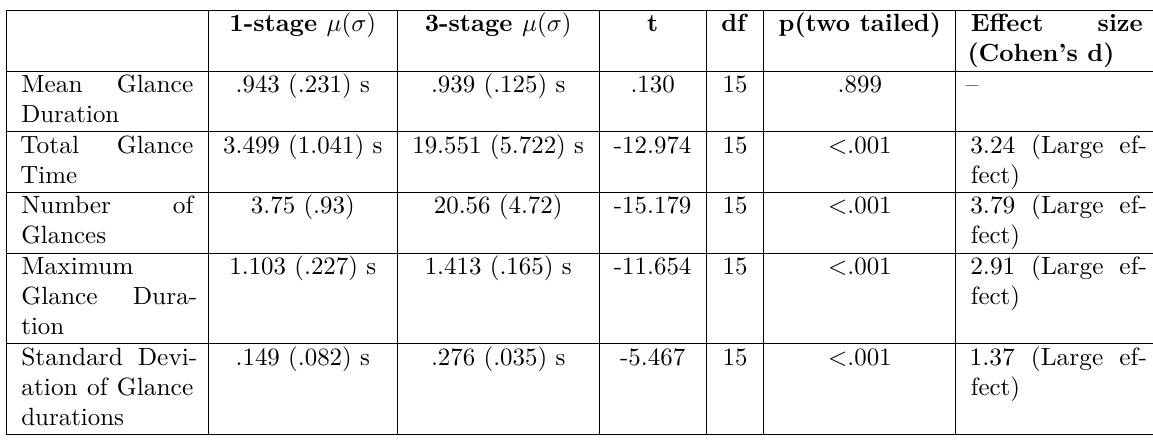
Table 3. Paired-Samples t-test – Glance characteristics.